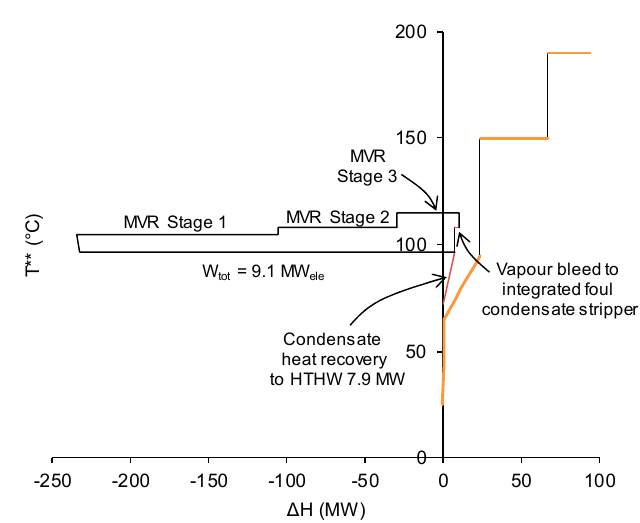
Figure 8. Total site heat integration of 3-stage mechanical vapour recompression (MVR) evaporator with the site steam and hot water utility system using the site utility grand composite curve.